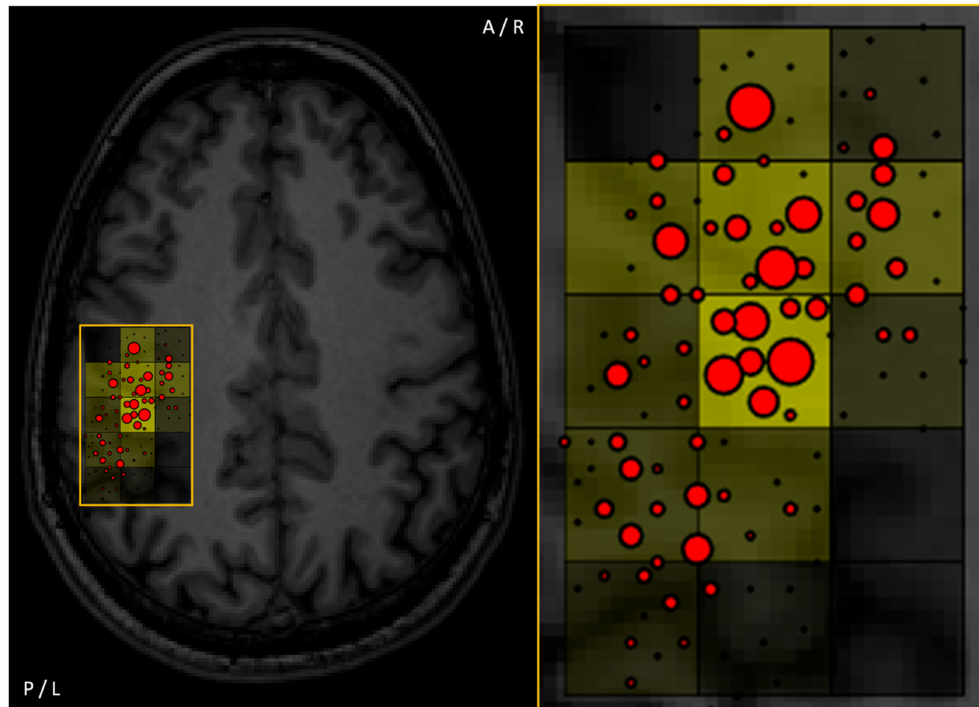
Figure 10. The visualized grid square size used was 10 mm × 10 mm, which is a quite commonly used size [146,149]. The stimulations were placed on average 2.6 mm apart. The individual stimulus locations are shown with red dots , the size of which is indicative of the associated MEP amplitude (the larger the amplitude, the larger the dot). The yellow colors in the grid squares indicate the size of the mean MEP amplitude for the MEPs induced by stimulating points within the grid square (the brighter the color, the higher the mean MEP